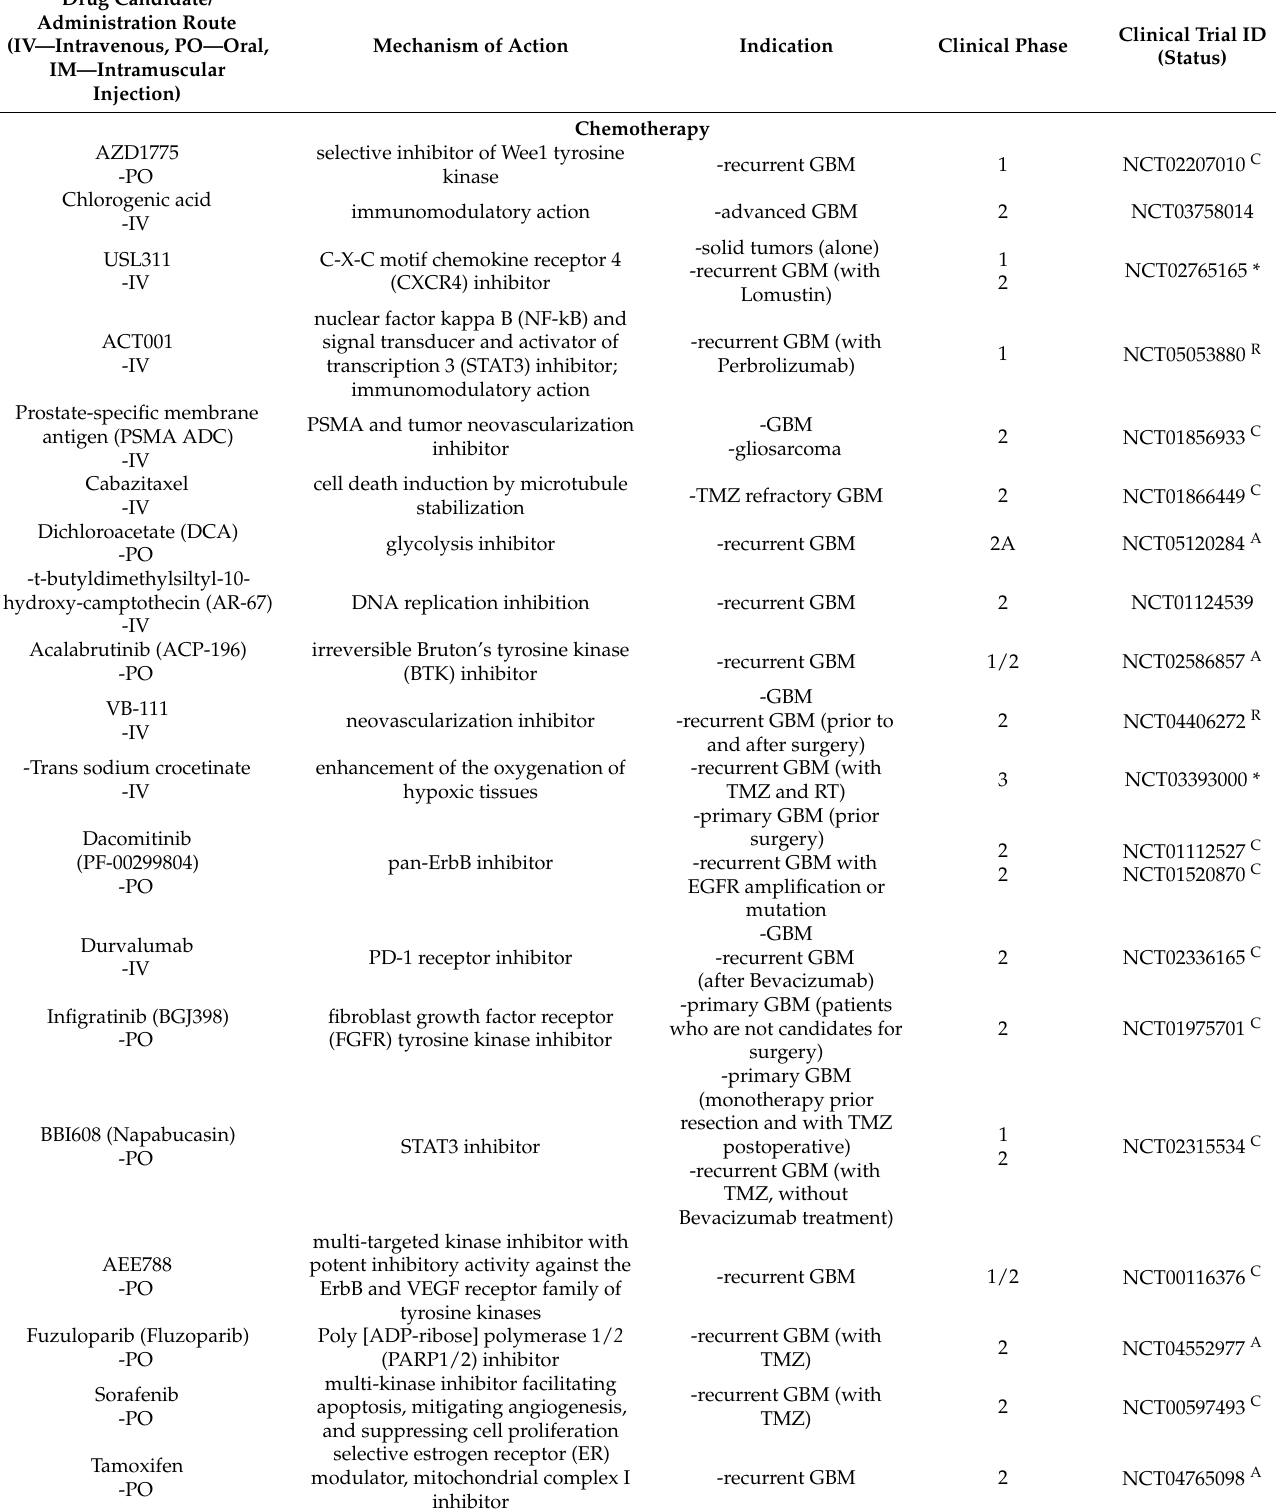
Table 1. Summary of clinical trials with drug candidates for GBM chemotherapy